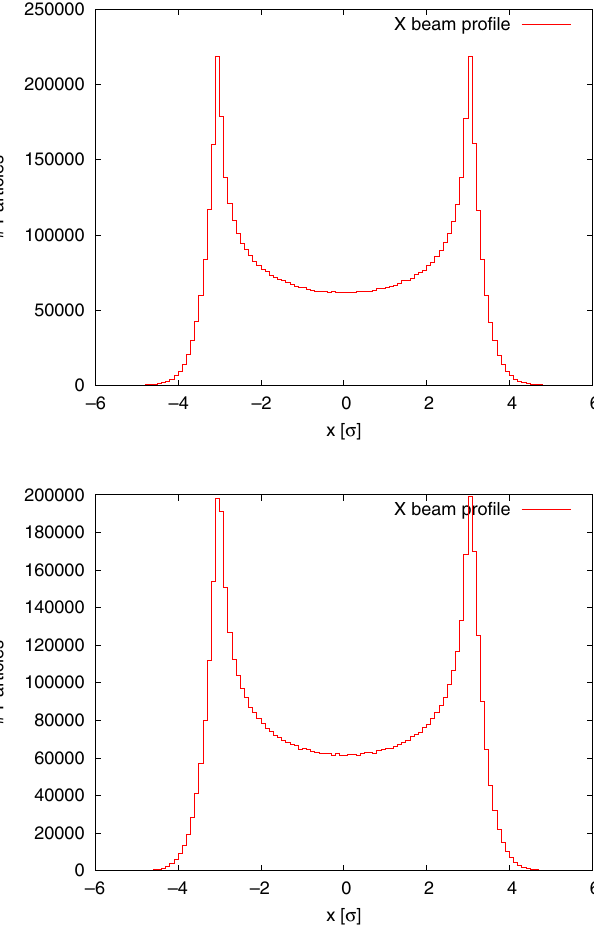
FIG. 5. Histograms of the horizontal beam distribution of SG II for the 1st turn (top) and for the 4496th turn